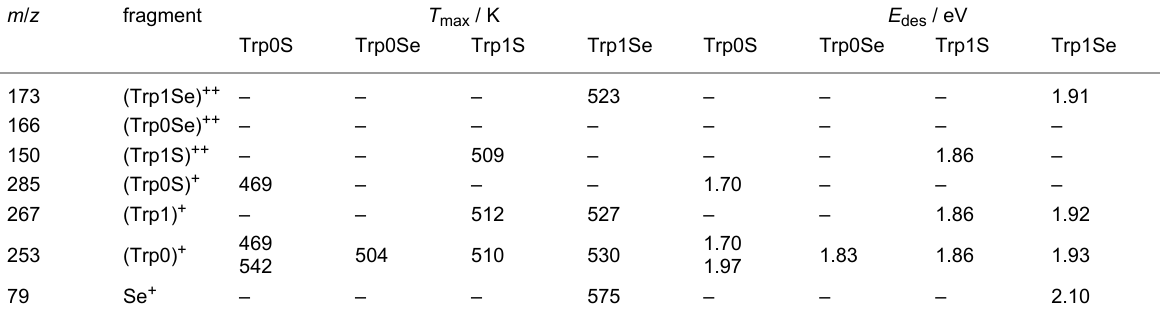
Table 4: Experimental desorption temperatures and energies as derived from the TDS data of the Trp0S-, Trp0Se-, Trp1S- and Trp1Se-SAMs. m /